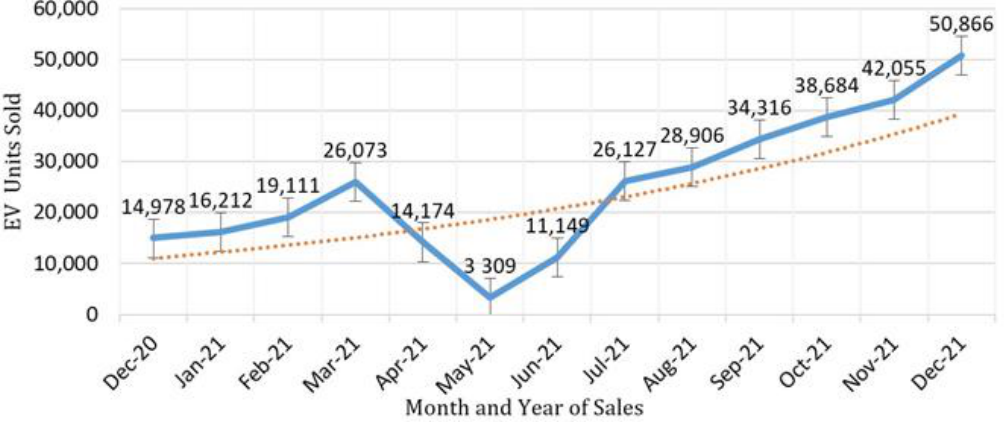
Figure 1. Sales figures represent EVs registered across 1379 regional transport offices (RTOs) in 33 states and union territories (UTs) in India.